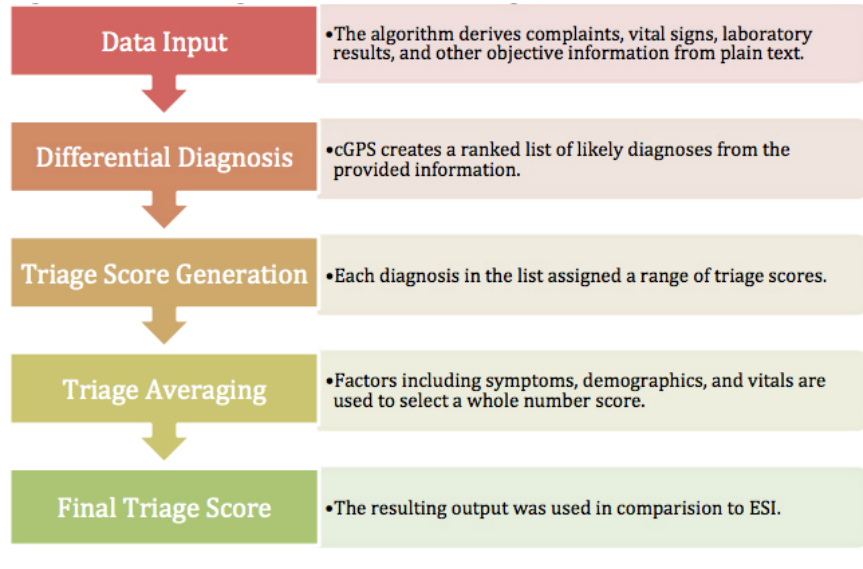
Figure 1. Overview of the algorithm used to derive the triage